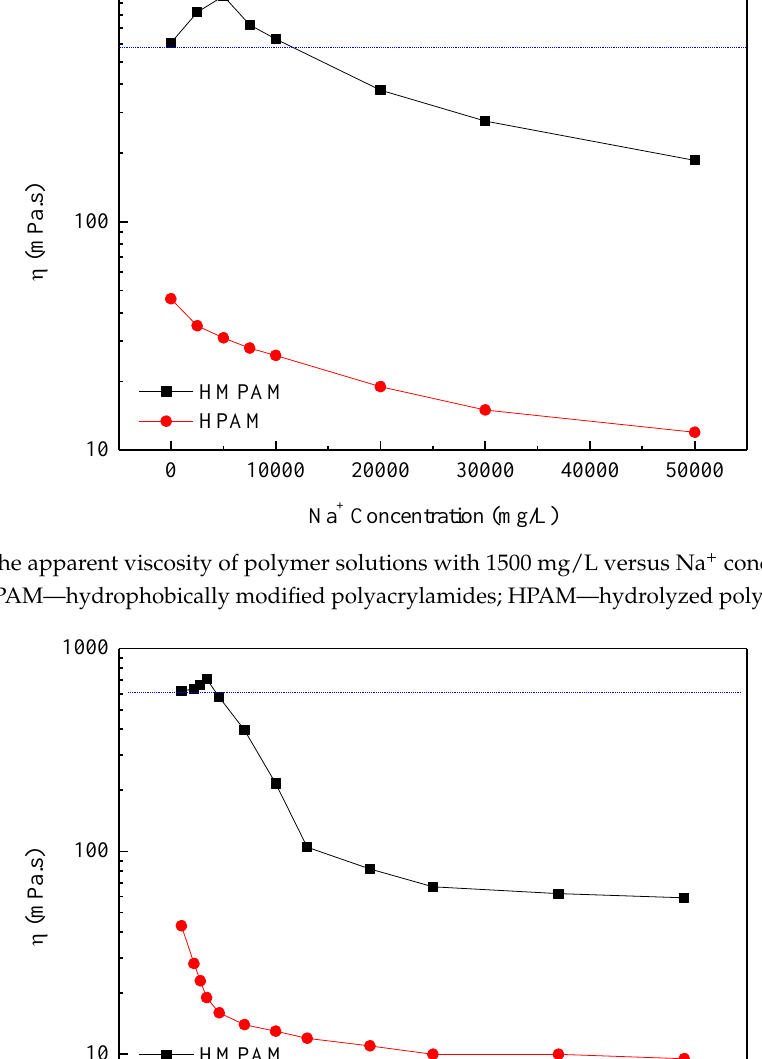
Figure 2. The apparent viscosity of polymer solutions with 1500 mg/L versus Na + concentration at 45 °C. HMPAM — hydrophobically modified polyacrylamides; HPAM — hydrolyzed polyacrylamide.